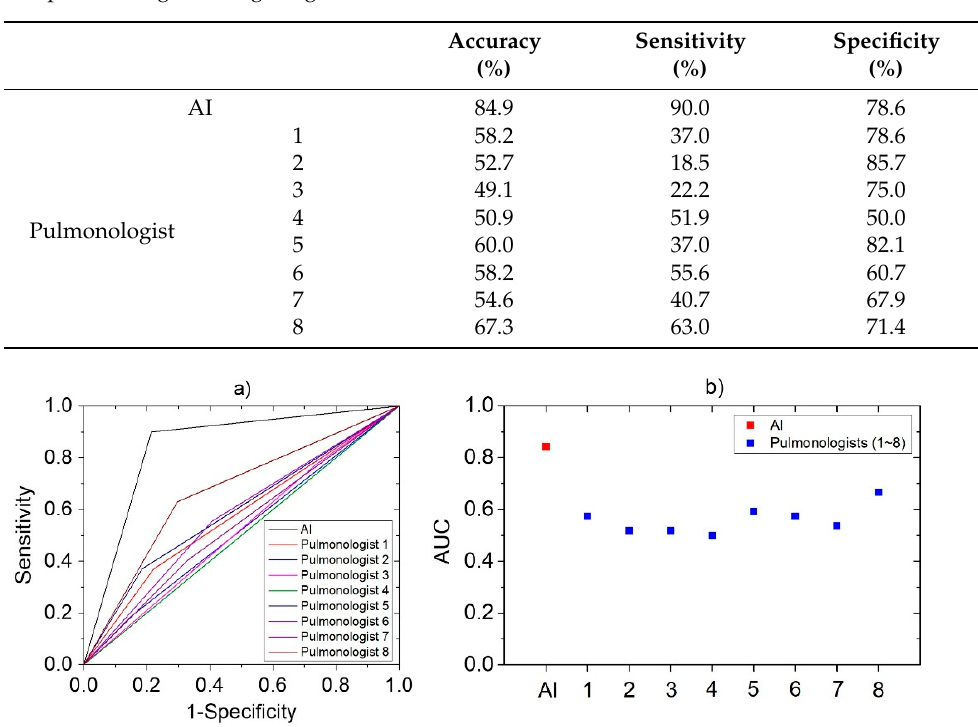
Table 3. Comparison of pneumonia diagnostic results between artificial intelligence-based algorithm and pulmonologists using cough sounds.